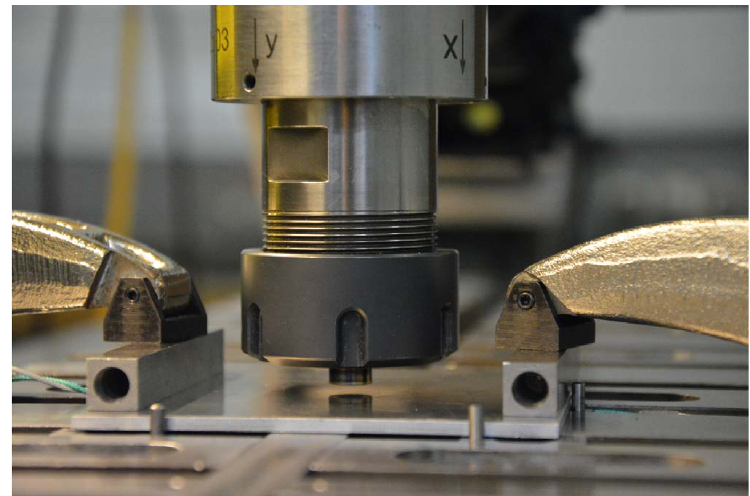
Figure 1. Experimental setup in starting position, with the telemetric system holding a tool (hollow cylinder), anvil, and fixtures.